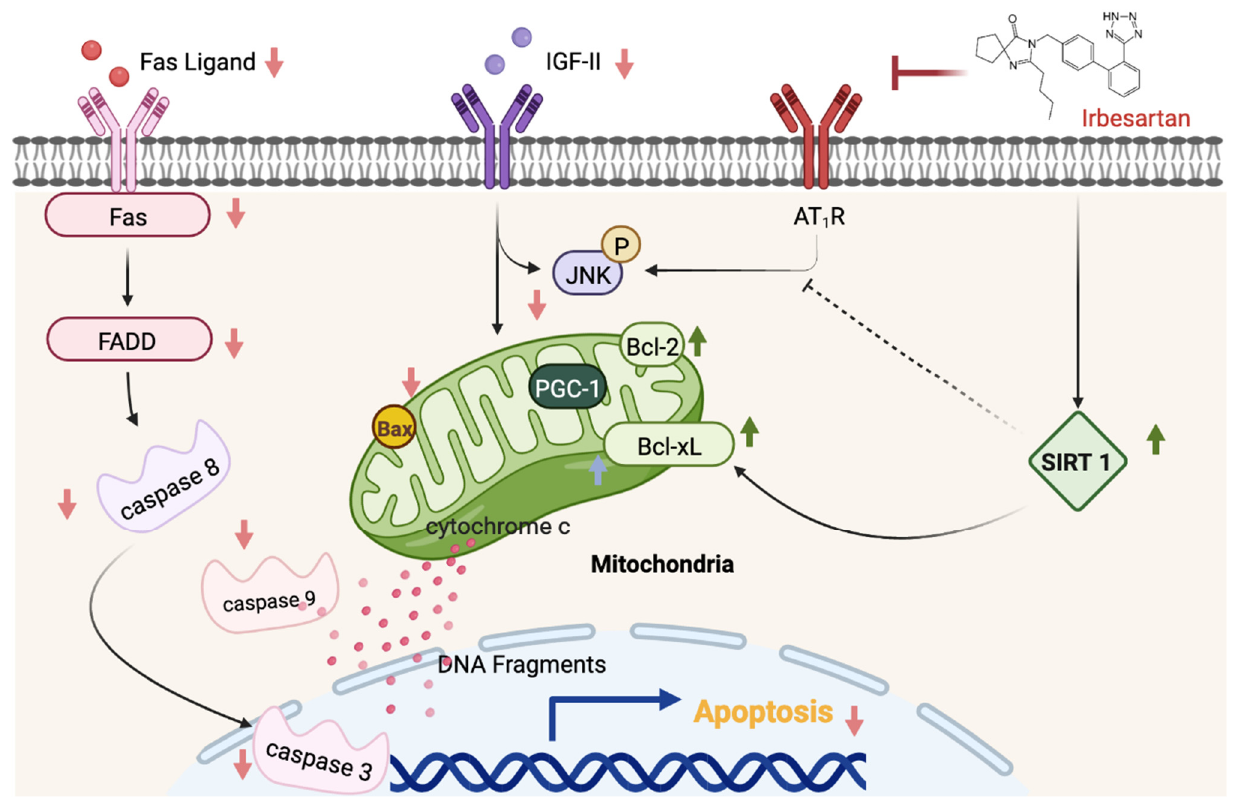
Figure 6. Hypothesized diagram. The proposed schematic diagram from the current study shows that the cardiac Fas/FasL-mediated (Fas Ligand, Fas, FADD, and active caspase-8) and the mitochondria-mediated apoptotic pathways (Bax, cytosolic cytochrome c, Active caspase-9, and Active caspase-3) were activated by hypertension through IGF-II and p -JNK activation. Moreover, the pro-survival protein of SIRT1 appeared to have a compensatory pro-survival response after hypertension. However, these cardiac Fas/FasL-mediated and mitochondria-mediated apoptotic pathways appear to be suppressed or not activated via the enhanced SIRT1/PGC-1 α pro-survival pathway (SIRT1, PGC-1, Bcl-2, and Bcl-xL) under hypertension after treated Irbesartan.